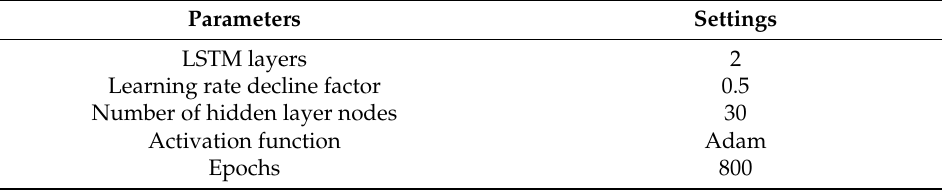
Table 3. LSTM neural network parameters.